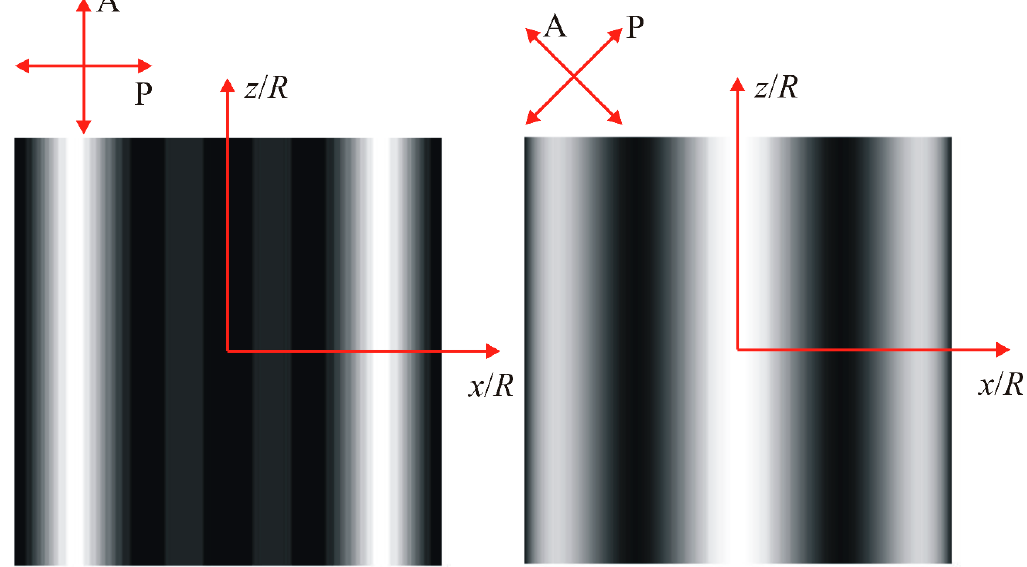
Figure 8. The same as for Figure 7, but for RT structure with Q RT = 1.